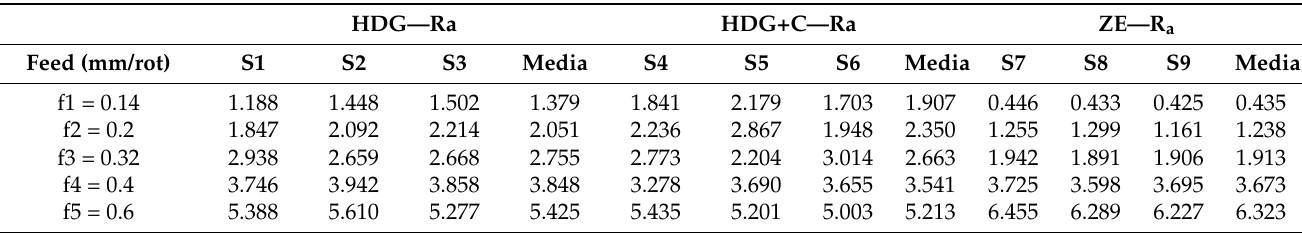
Table 11. Centralization of R a measurements for each galvanizing technology